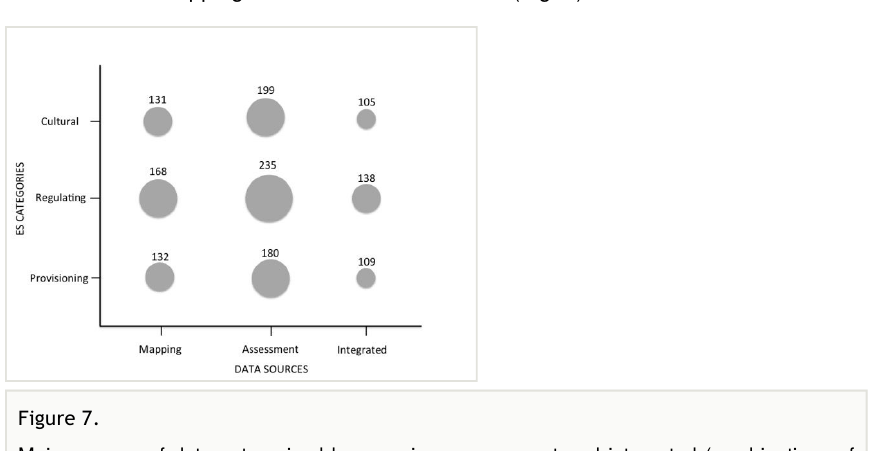
Main sources of data categorised by mapping, assessment and integrated (combinations of both) that could be applied in relation to ES